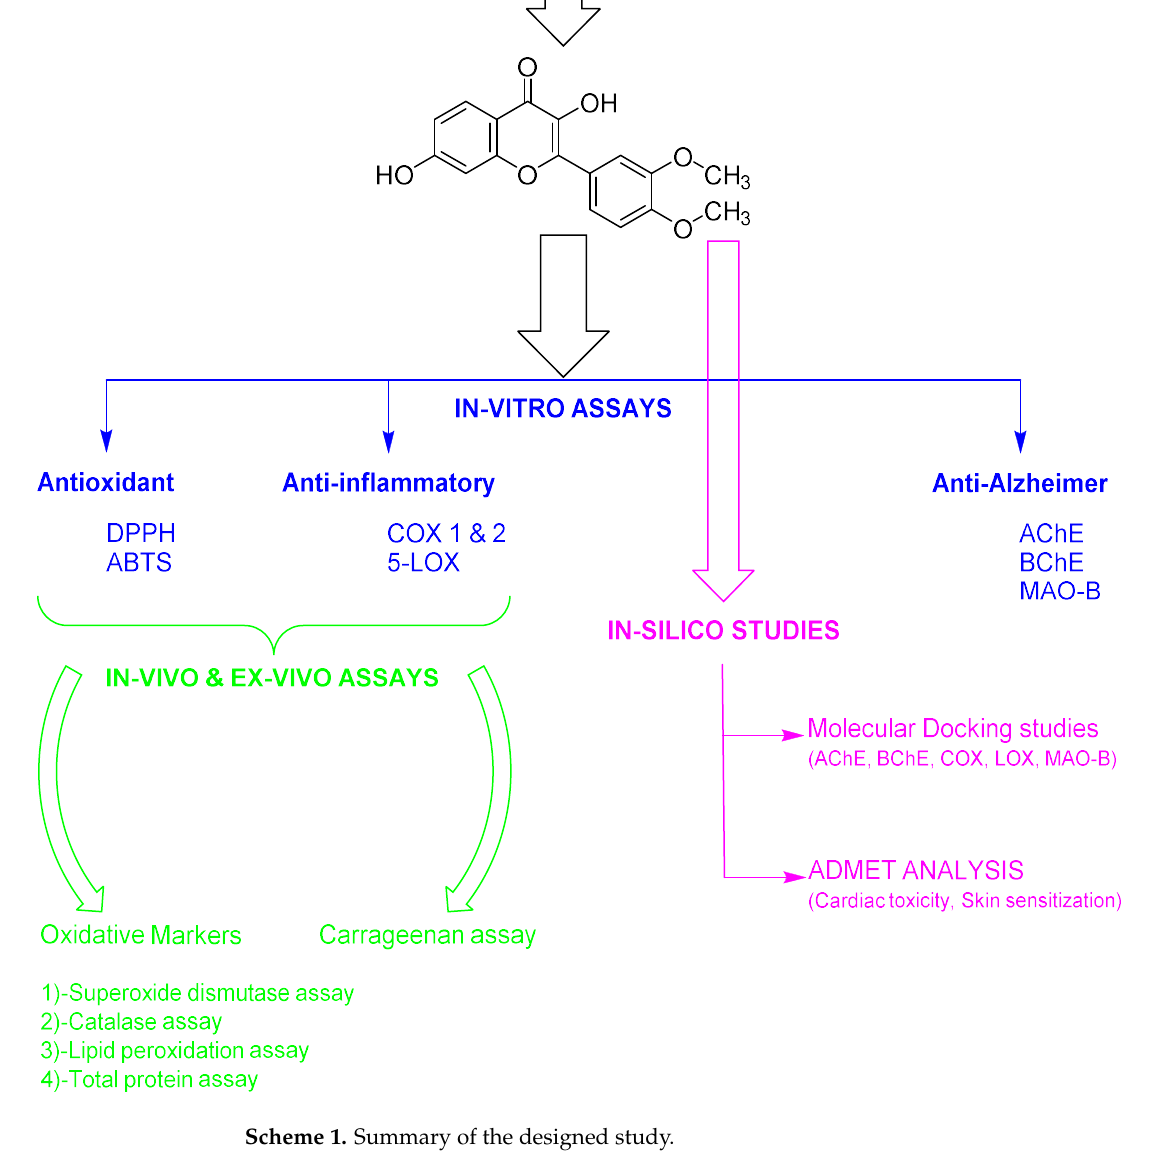
Scheme 1. Summary of the designed study.